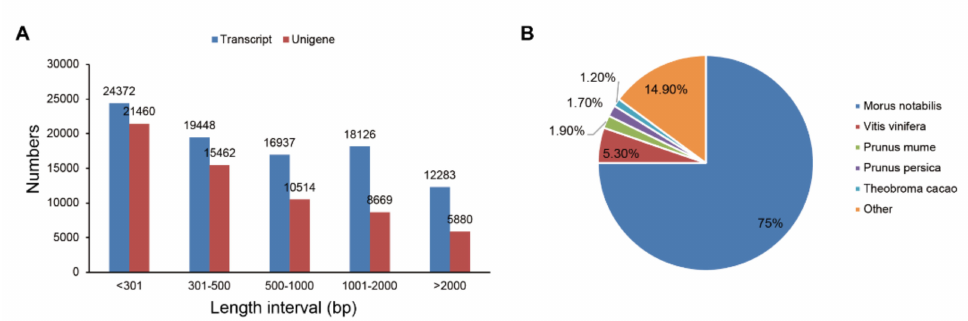
Figure 1. De novo transcriptome assembly of M. laevigata . ( A ) The length distribution of the M. laevigata transcripts and unigenes; ( B ) species distribution of the unigene BLAST results against the Nr database with the cuto ff E-value of 10 − 5 .